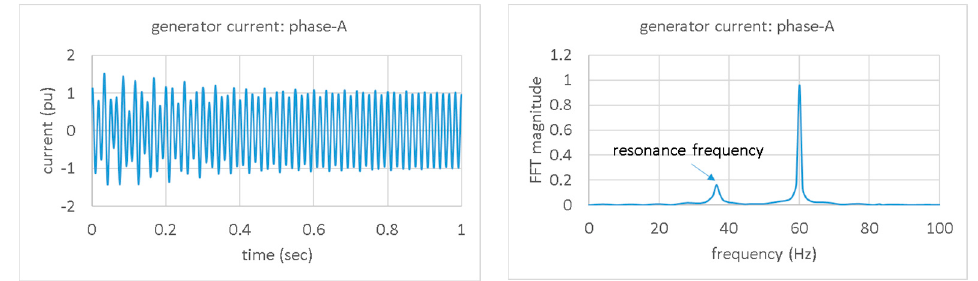
Figure 6. Generator current and its frequency spectrum.